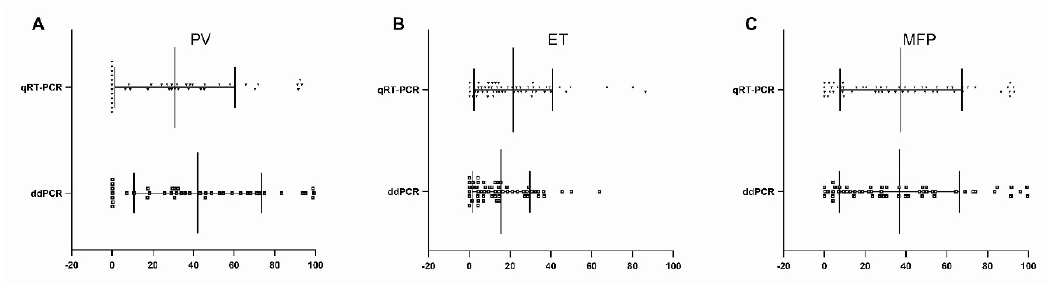
Figure 3. Bland–Altman analysis was used to plot differences between measurements by qPCR and ddPCR versus the mean of the sample. Dotted lines indicate bias (mean difference) and 95% of agreement (upper and lower limit +/− 2SD) between the two given methods.